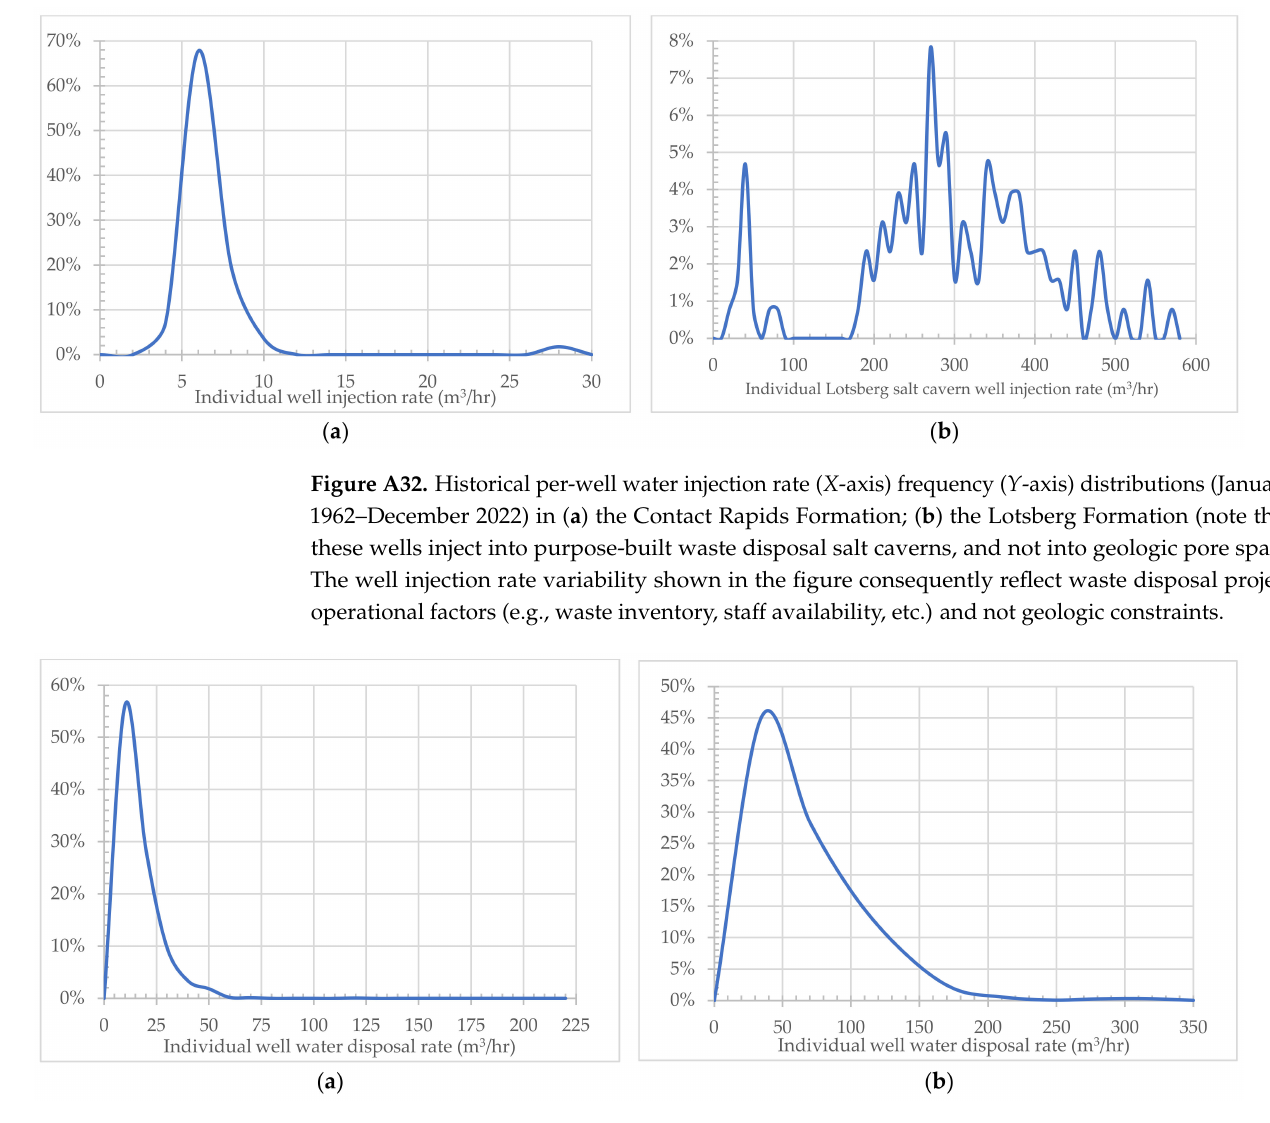
Figure A33. Historical per-well water injection rate ( X -axis) frequency ( Y -axis) distributions (January 1962–December 2022) in ( a ) the Granite Wash Formation; ( b ) the Basal Sandstone